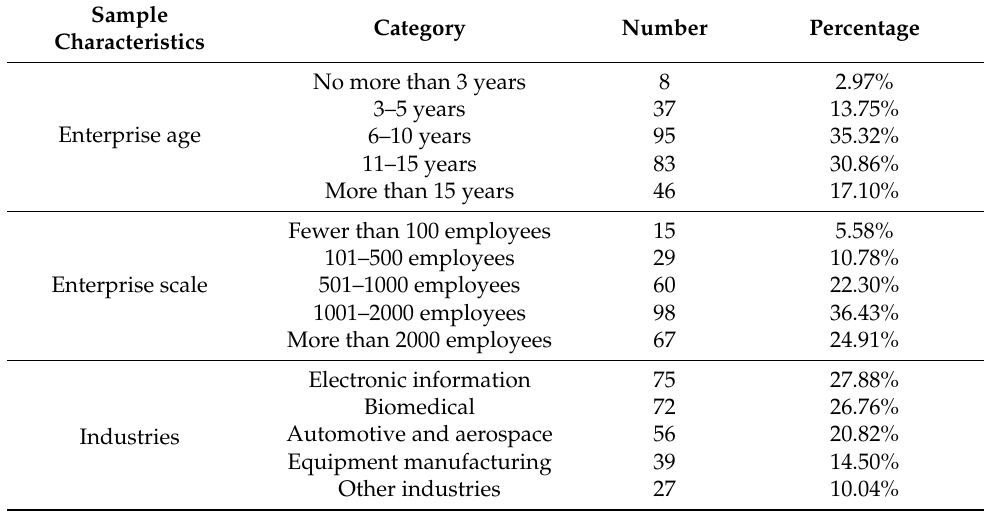
Table 2. Distribution characteristics of the enterprise